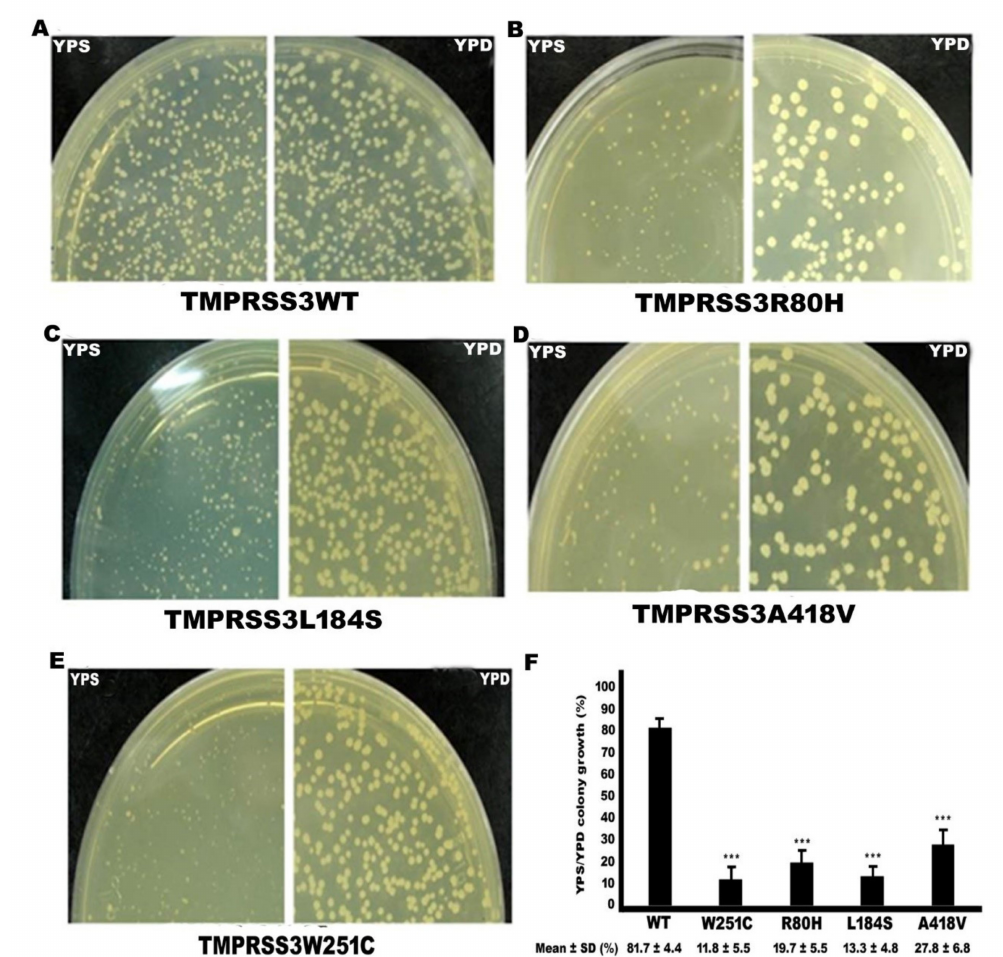
Figure 3. Assay of the catalytic activity of TMPRSS3 by site-specific proteolysis (sGASP). Transformants expressing both the STE13-substrate-invertase fusion protein and wild type (WT) or variants of the STE13-TMPRSS3 protein, including ( A ) TMPRSS3WT, ( B ) TMPRSS3R80H, ( C ) TMPRSS3L184S, ( D ) TMPRSS3A418V, and ( E ) TMPRSS3W251C, were plated on non-selective (glucose-YPD (yeast extract peptone dextrose)) and selective (sucrose-YPS (yeast extract peptone sucrose)) plates. TMPRSS3W251C mutant was as a positive control. ( F ) Quantitative assay of growth rate of yeast colony on sucrose plates. They were calculated by dividing the number of colony on sucrose plates by the number of colony on glucose plates ( n = 5). ***: Asterisks denote the significant p -value < 0.001.; STE13: Ste13p (Gene ID: